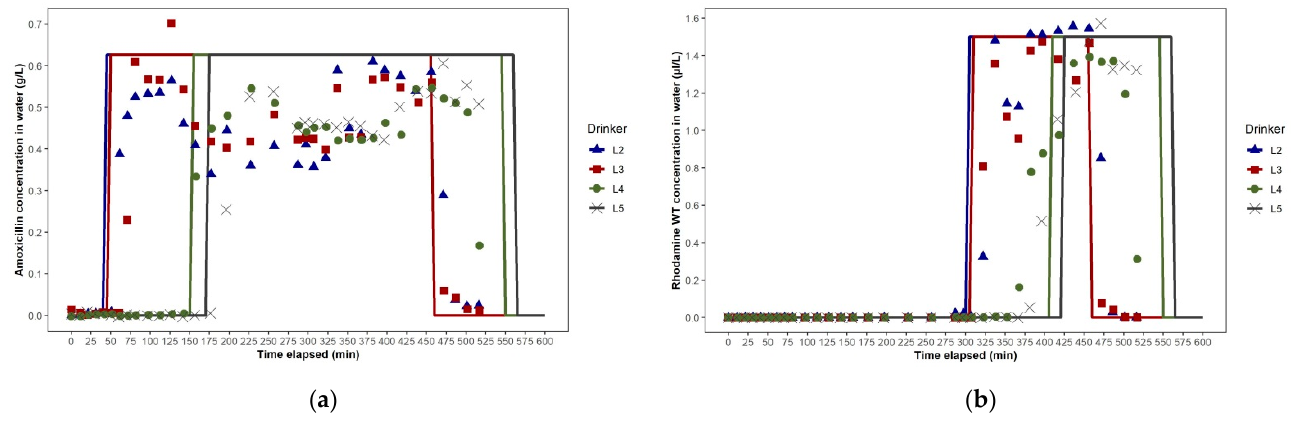
Figure 5. Study 1a dosing event in Building A: ( a ) amoxicillin concentration—time plots for drinkers L2, L3, L4 and L5, as predicted using EPANET (lines) and as observed (points), ( b ) rhodamine WT concentration—time plots for drinkers L2, L3, L4 and L5, as predicted using EPANET (lines) and as observed (points).